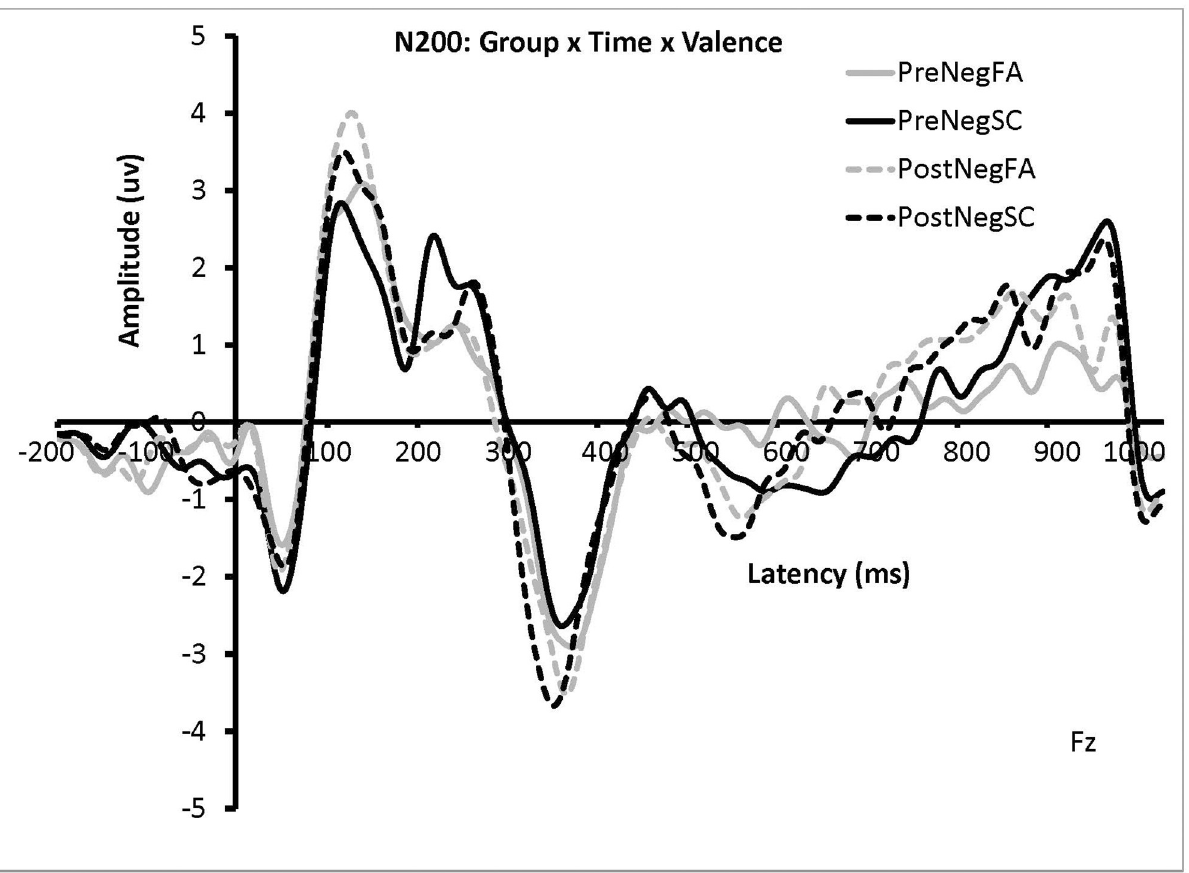
Fig 3. Grand average waveforms showing the effect of group and time on negative prime trials on N2 amplitude at channel Fz. The solid lines indicate the grand average waveforms for the negative-valence Flanker trials pre-training. The dashed lines indicate the grand average waveforms for the negative-valence Flanker trials